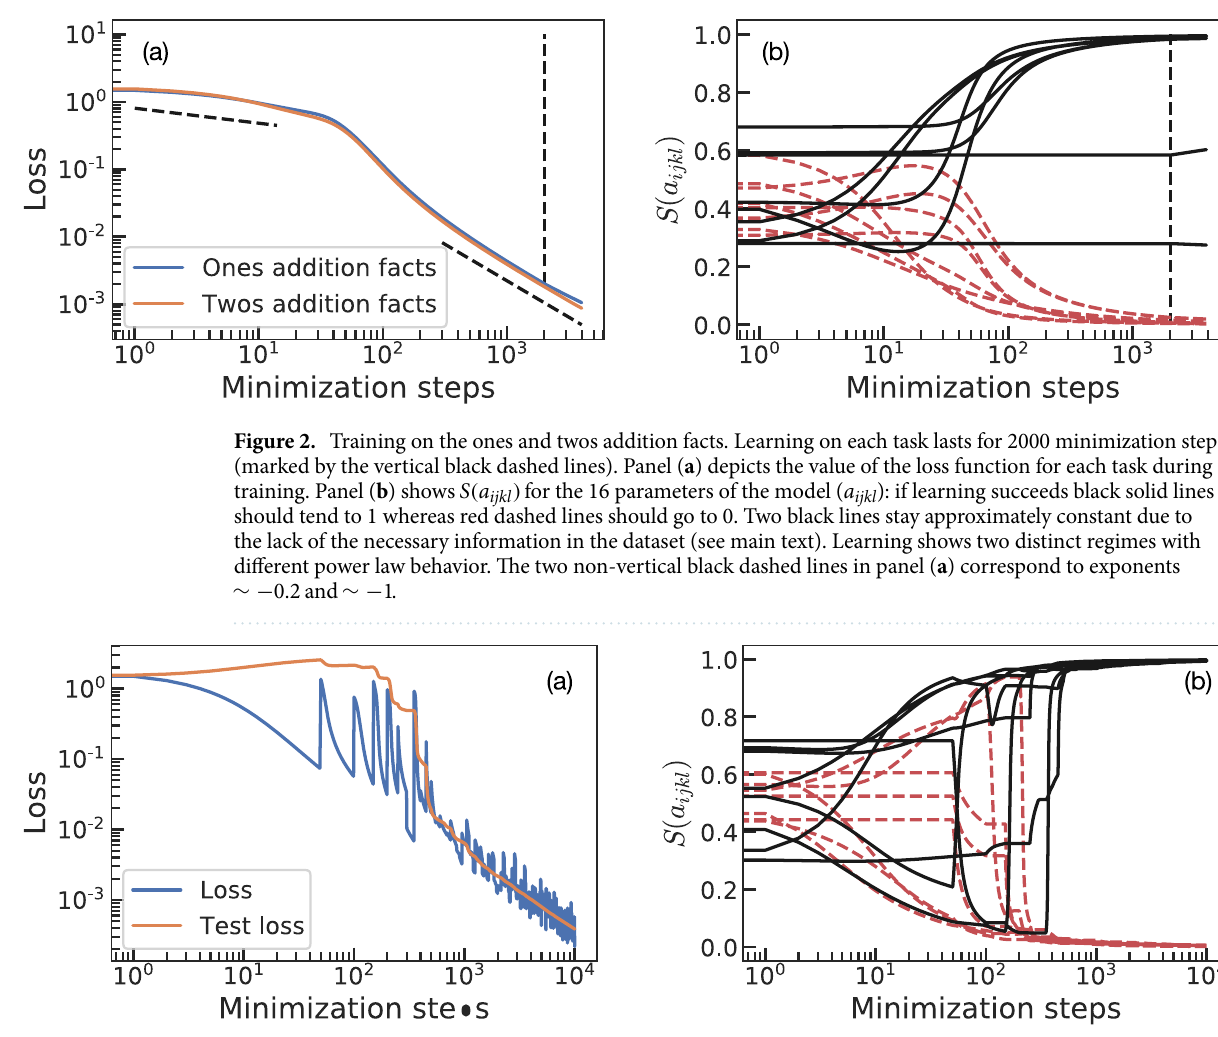
Figure 3. Learning one sample at a time. Panel ( a ) displays training and test loss functions during learning. We train on a new sample ( N 1 + N 2 = ˜ N 4 ) chosen at random every 50 minimization steps for 10, 000 steps (a total of 200 samples). Test loss is always computed with the same 100 samples that are not in the training dataset. Panel ( b ) shows S ( a ijkl ) for the 16 parameters of the model ( a ijkl ): if learning succeeds black solid lines should tend to 1 whereas red dashed lines should go to